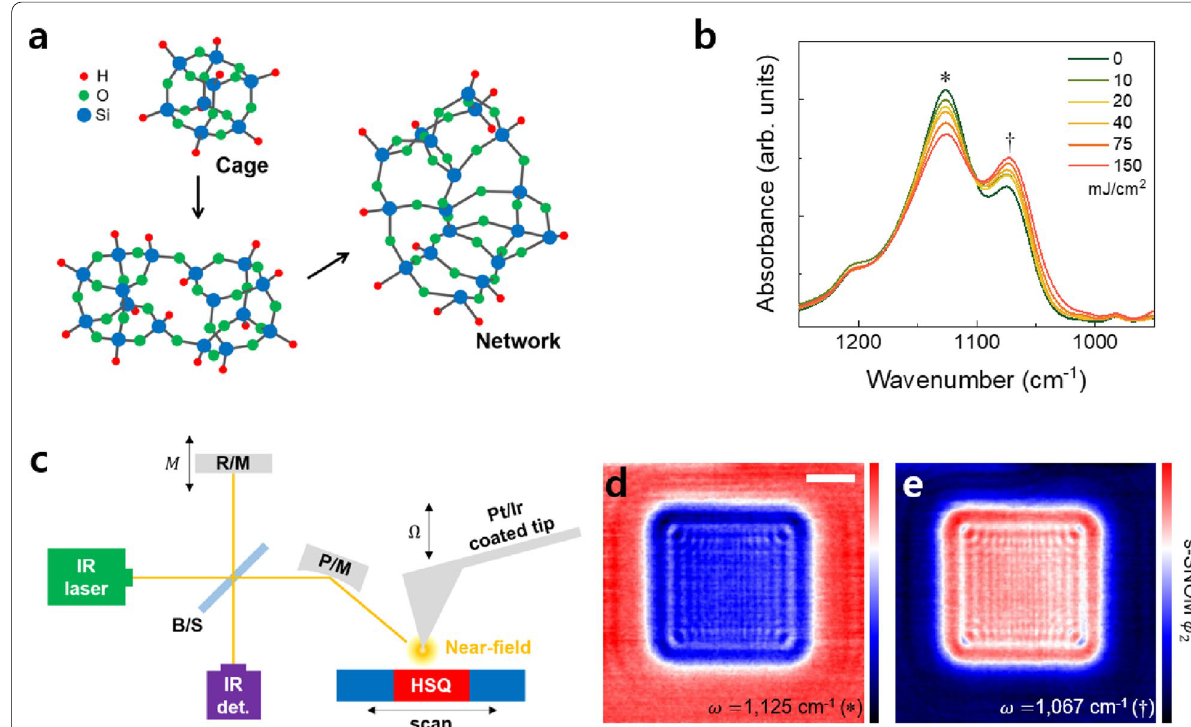
Fig. 1 a Schematic illustration of the curing process of the hydrogen silsesquioxane (HSQ) resists from a cage‑like structure to a network structure. b Fourier transform infrared (FTIR) spectra of as‑cast and extreme ultraviolet (EUV)‑exposed HSQ films for the range of Si–O–Si vibration. c Schematic illustration of scattering‑type scanning near‑field optical microscope (s‑SNOM, beam splitter B/S, parabolic mirror P/M, reference mirror R/M). s‑SNOM images of ( d ) cage‑like structure (1125 cm − 1 ) and e network structure (1067 cm − 1 ) for 150 mJ/cm 2 . The red color indicates higher infrared absorption. The scale bar is 3